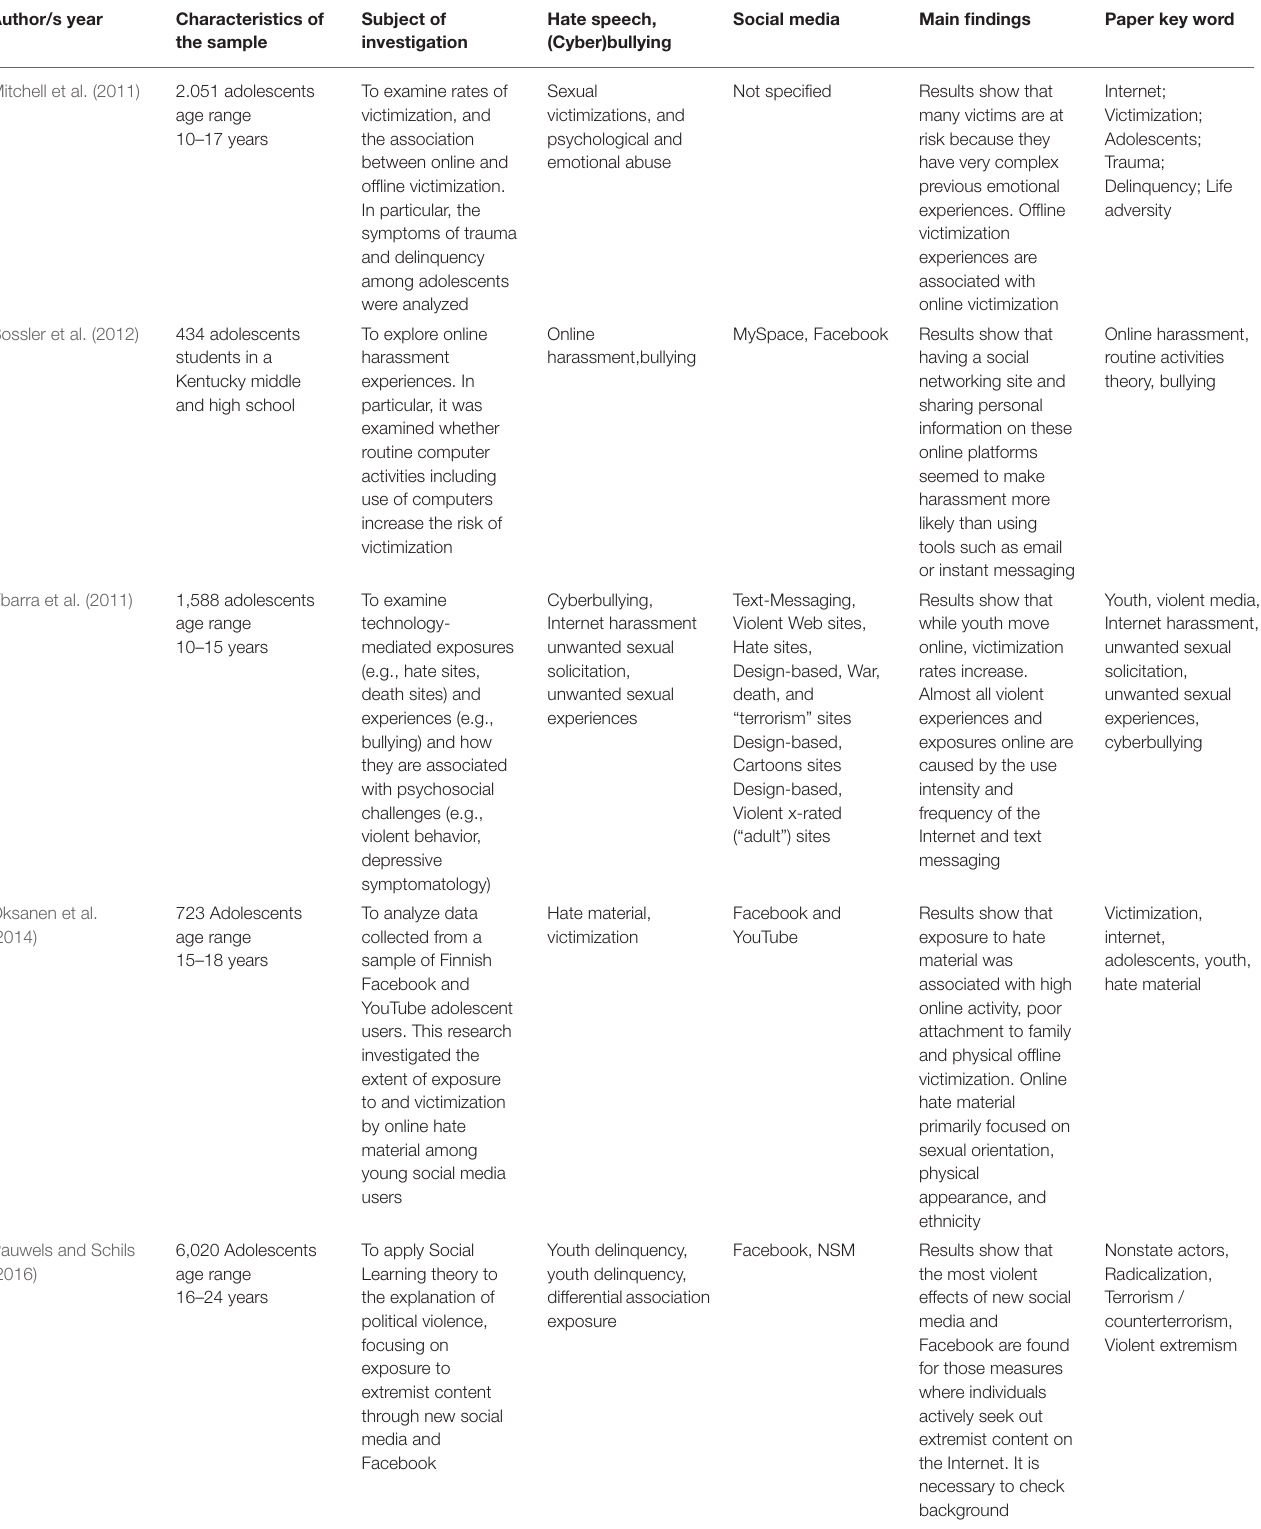
TABLE 1 | Main characteristics of the papers included in the